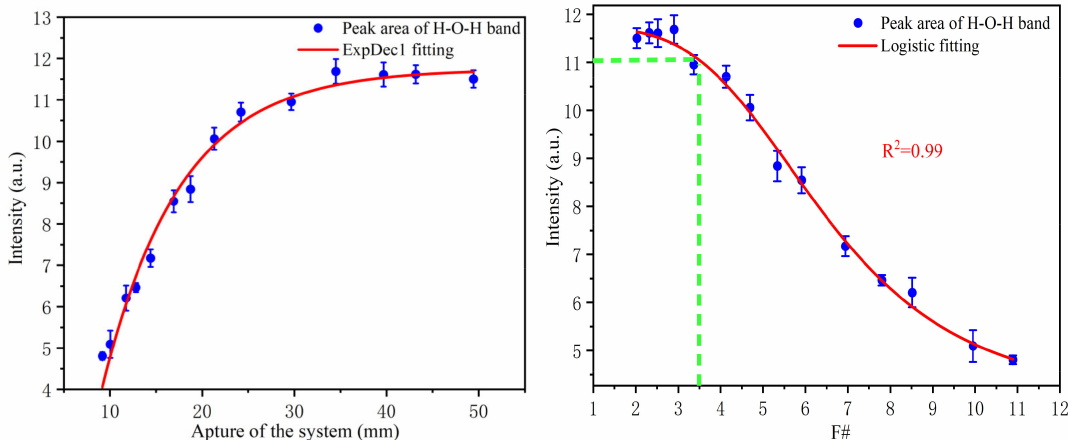
Figure 4. The experiment results showing the collected Raman signal intensity of water as a function of the aperture ( left ) and F/# ( right ) of the system.